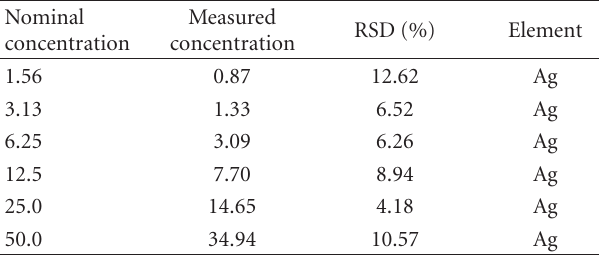
Table 3: Concentration of Ag-NPs ( µ g/L) measured using